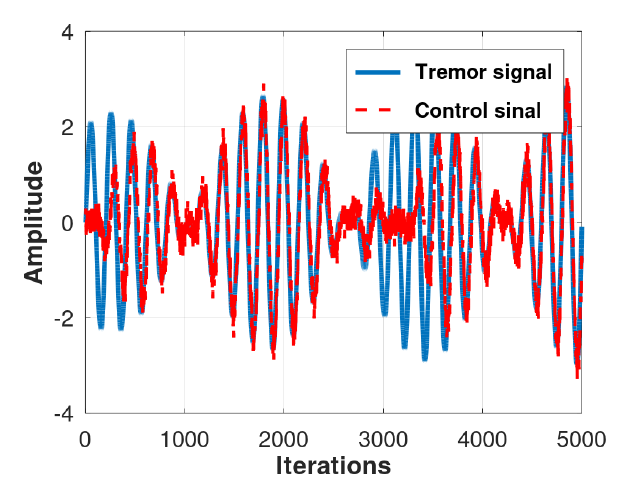
Figure 13. Control evaluation results produced by the FsinX-LMS algorithm for 30 runs of a Monte Carlo simulation.